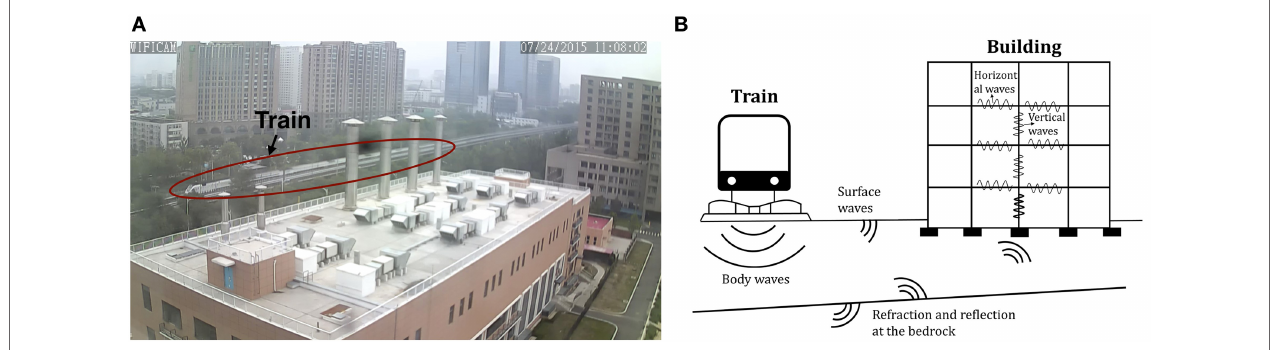
FIGURE 1 | (A) Train is passing by Rohm building (photo taken by the camera installed on the top of Rohm building); (B) physical insights of wave propagation from train to building.